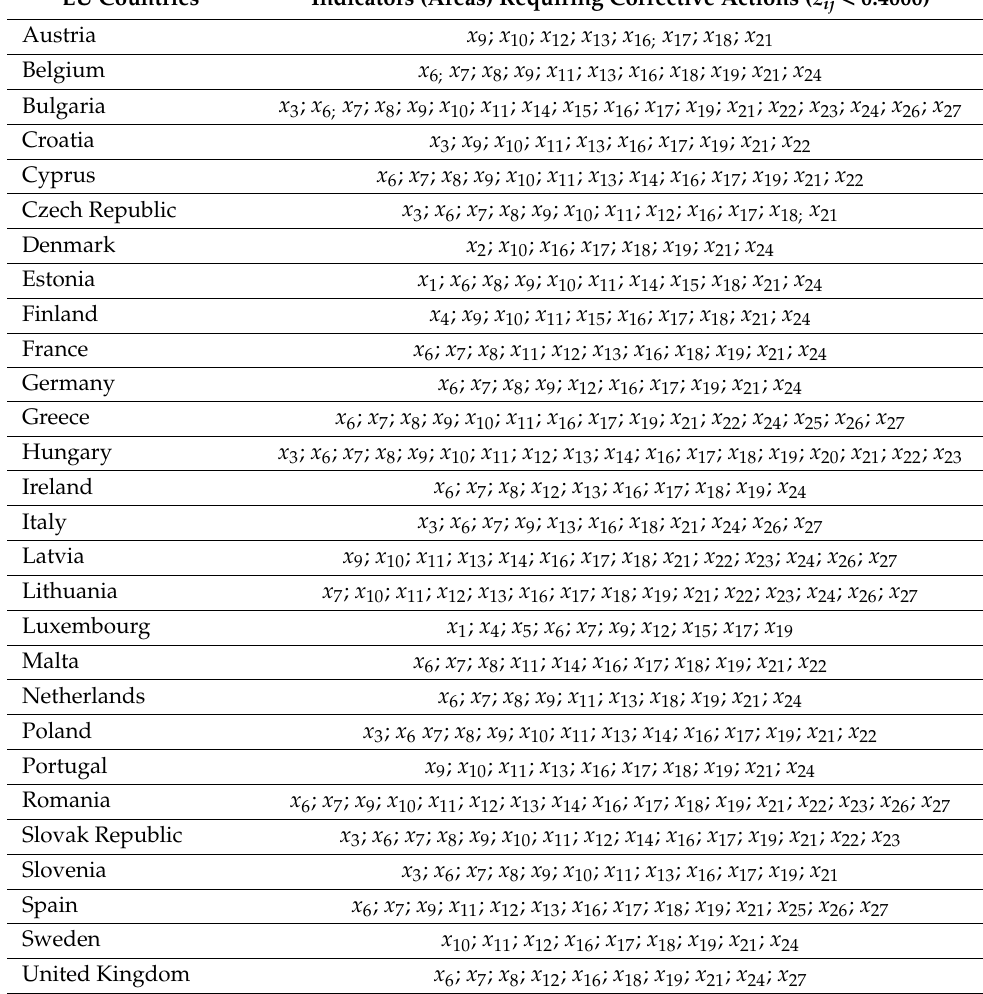
Table 3. Challenges for EU countries on the road to GE. EU Countries Indicators (Areas) Requiring Corrective Actions ( z ij <